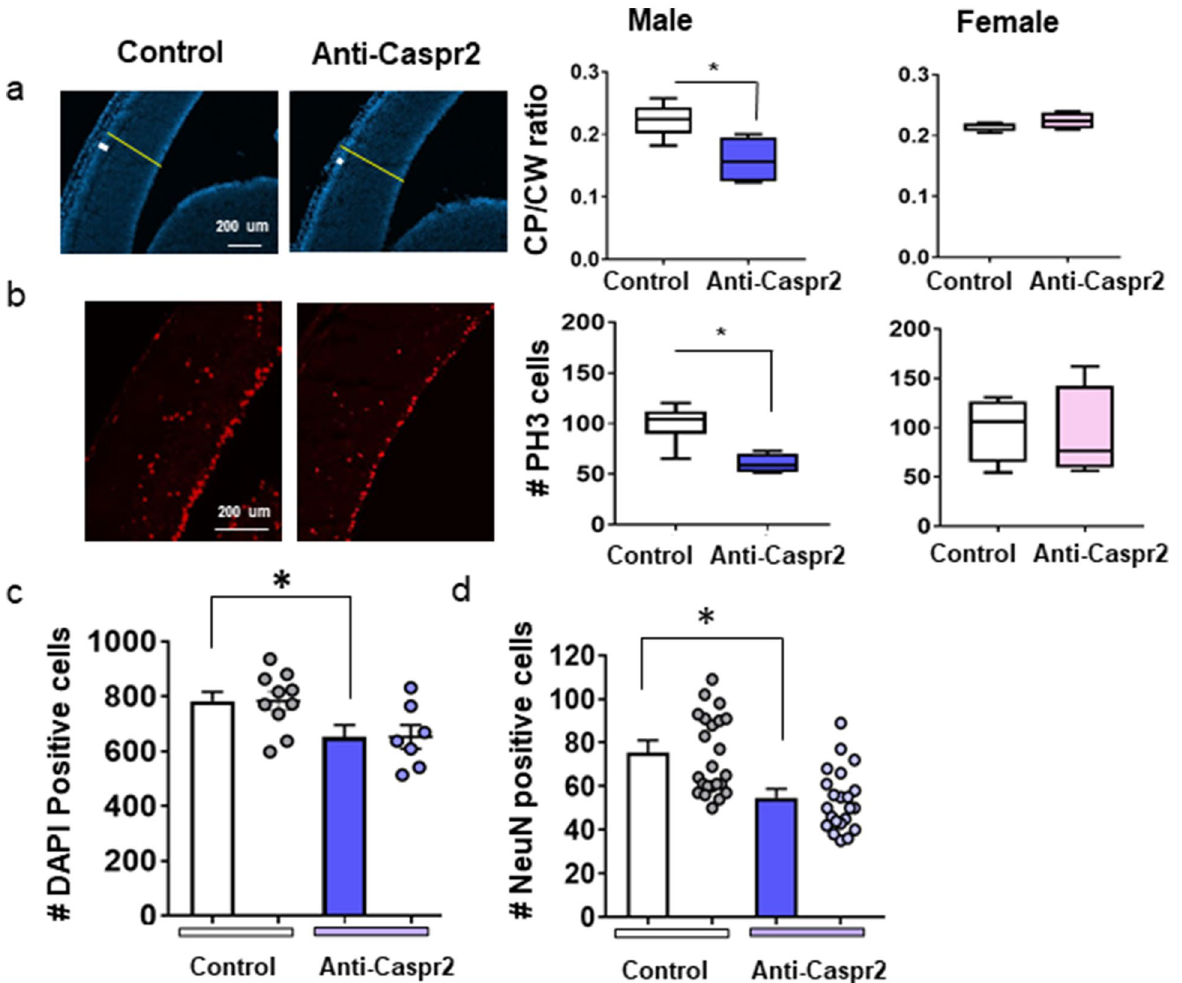
Right , quantification of the ratio of CP to CW. Mann Whitney, Male U = 1 * P < 0.05, Female U = 5, n.s. ( B ) Left, PH3 + staining of mitotic cells. Right, quantification of PH3 + . Mann Whitney, Male U = 1 * P < 0.05, Female U = 7, n.s ( A , B ) Male, Control n = 6, Anti-Caspr2 n = 4; Female, Control, Anti-Caspr2, n = 4; 3 litters each. ( C ) Anti-Caspr2 male fetuses (E15.5) display a reduced number of DAPI positive cells across the cortex. Control n = 10, Anti-Caspr2 n = 7, 3 litters each. t-test, t(15) = 2.433, * P < 0.05. ( D ) Analysis of the average of counts from 2 to 4 sections per male mouse of NeuN positive neurons in the deep layers of the entorhinal cortex . Dots represent number of NeuN positive cells counts in a section. Control n = 7, 5 litters, Anti-Caspr2 n = 7, 4 litters. t-test, t(12) = 2.929, * P <